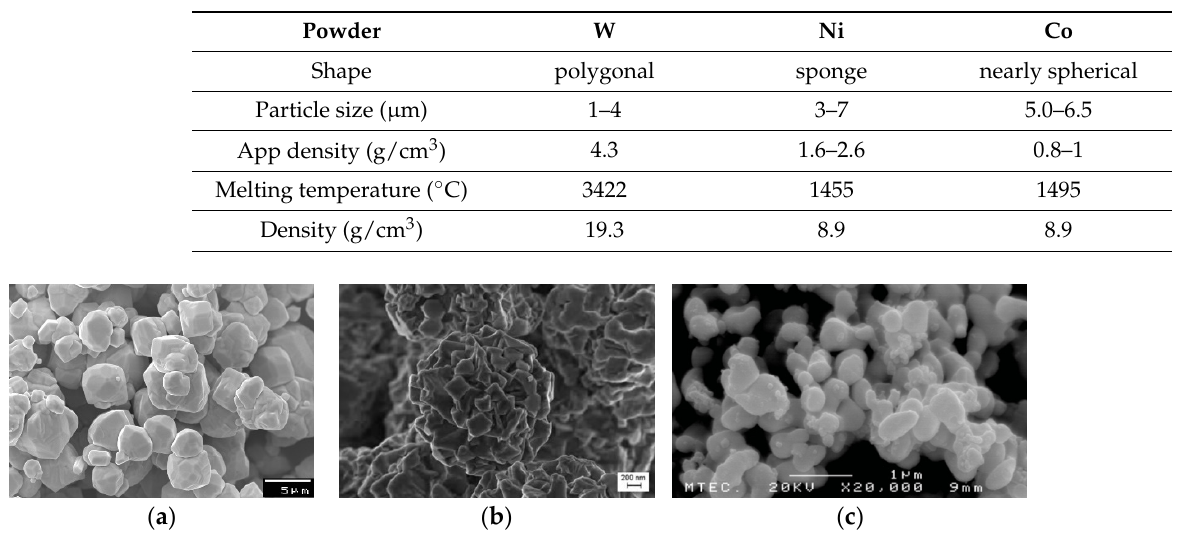
Table 1. Characteristics of the elemental powders.